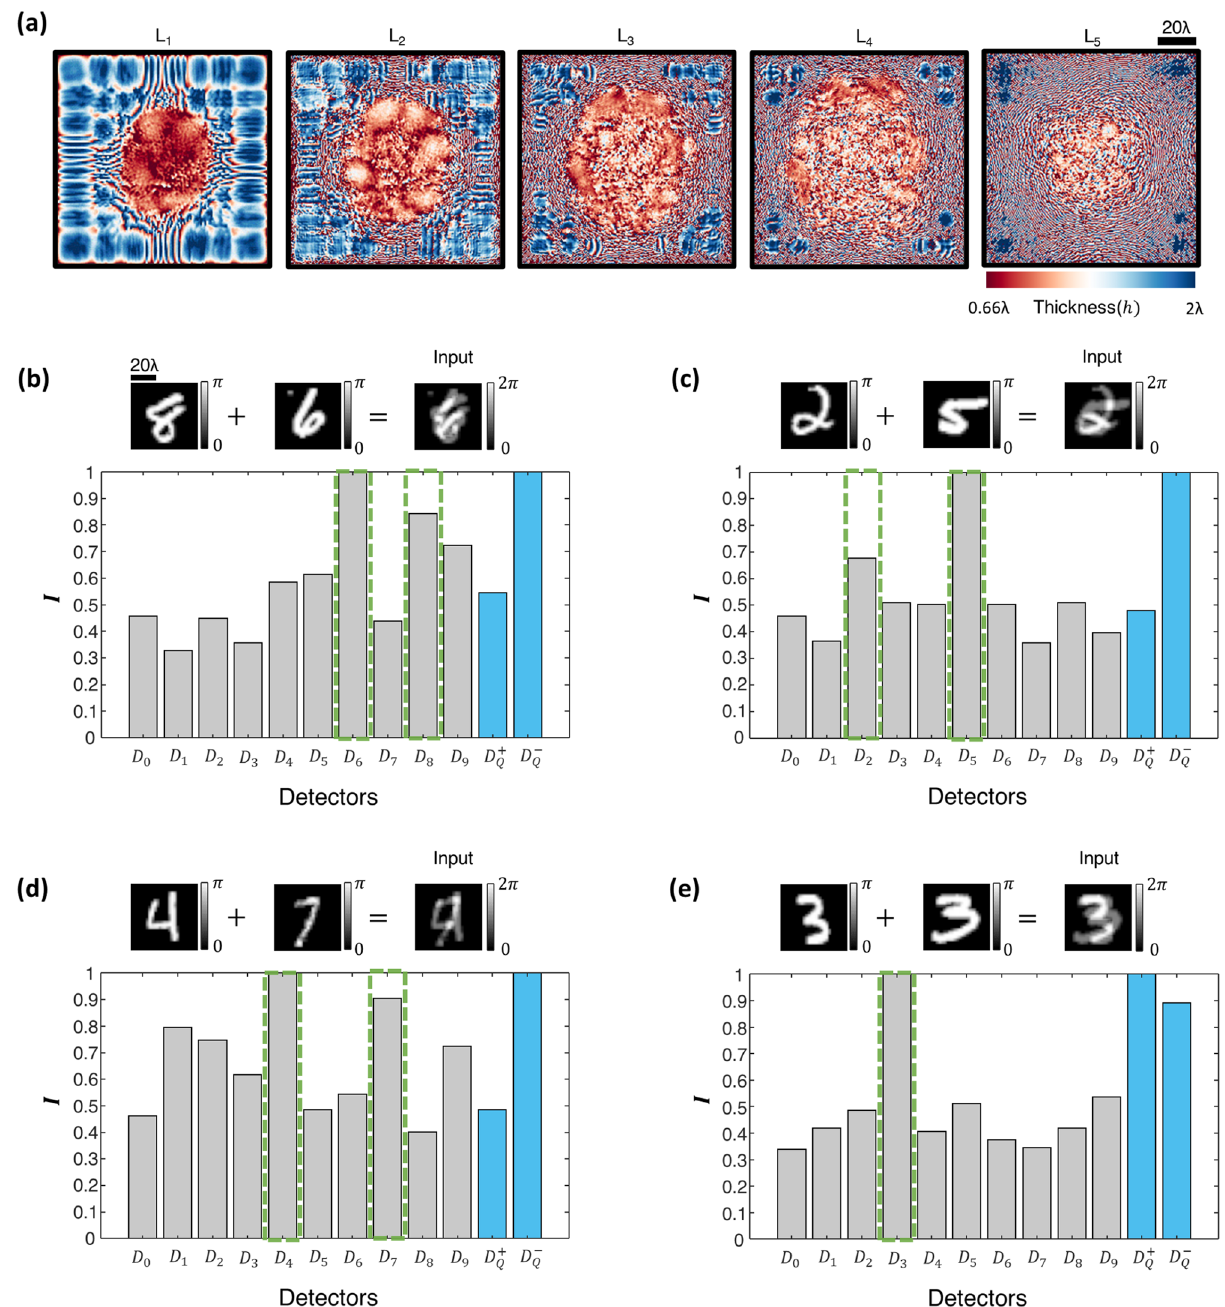
Figure 4. All-optical classification of spatially-overlapping phase objects using the diffractive optical network D 2 NN-D2, based on the detector layout scheme D-2 shown in Fig. 1d. ( a ) The thickness profiles of the diffractive layers constituting the diffractive optical network D 2 NN-D2 at the end of its training. This network achieves 82.61% blind inference accuracy on the test image set T 2 . ( b – e ), Top: Individual phase objects (examples) and the resulting input phase distribution created by their spatial overlap at the input field-of-view. < I Bottom: The normalized optical signals, I , synthesized by D 2 NN-D2 at its output detectors. For I D + D − Q , the Q largest two optical signals correctly reveal the classes of the overlapping input phase objects (indicated with the ≥ I green rectangular frames in ( b – d ). For I D + D − Q , the largest optical signal correctly reveals the class of the Q overlapping input phase objects (indicated with the green rectangular frame in ( e